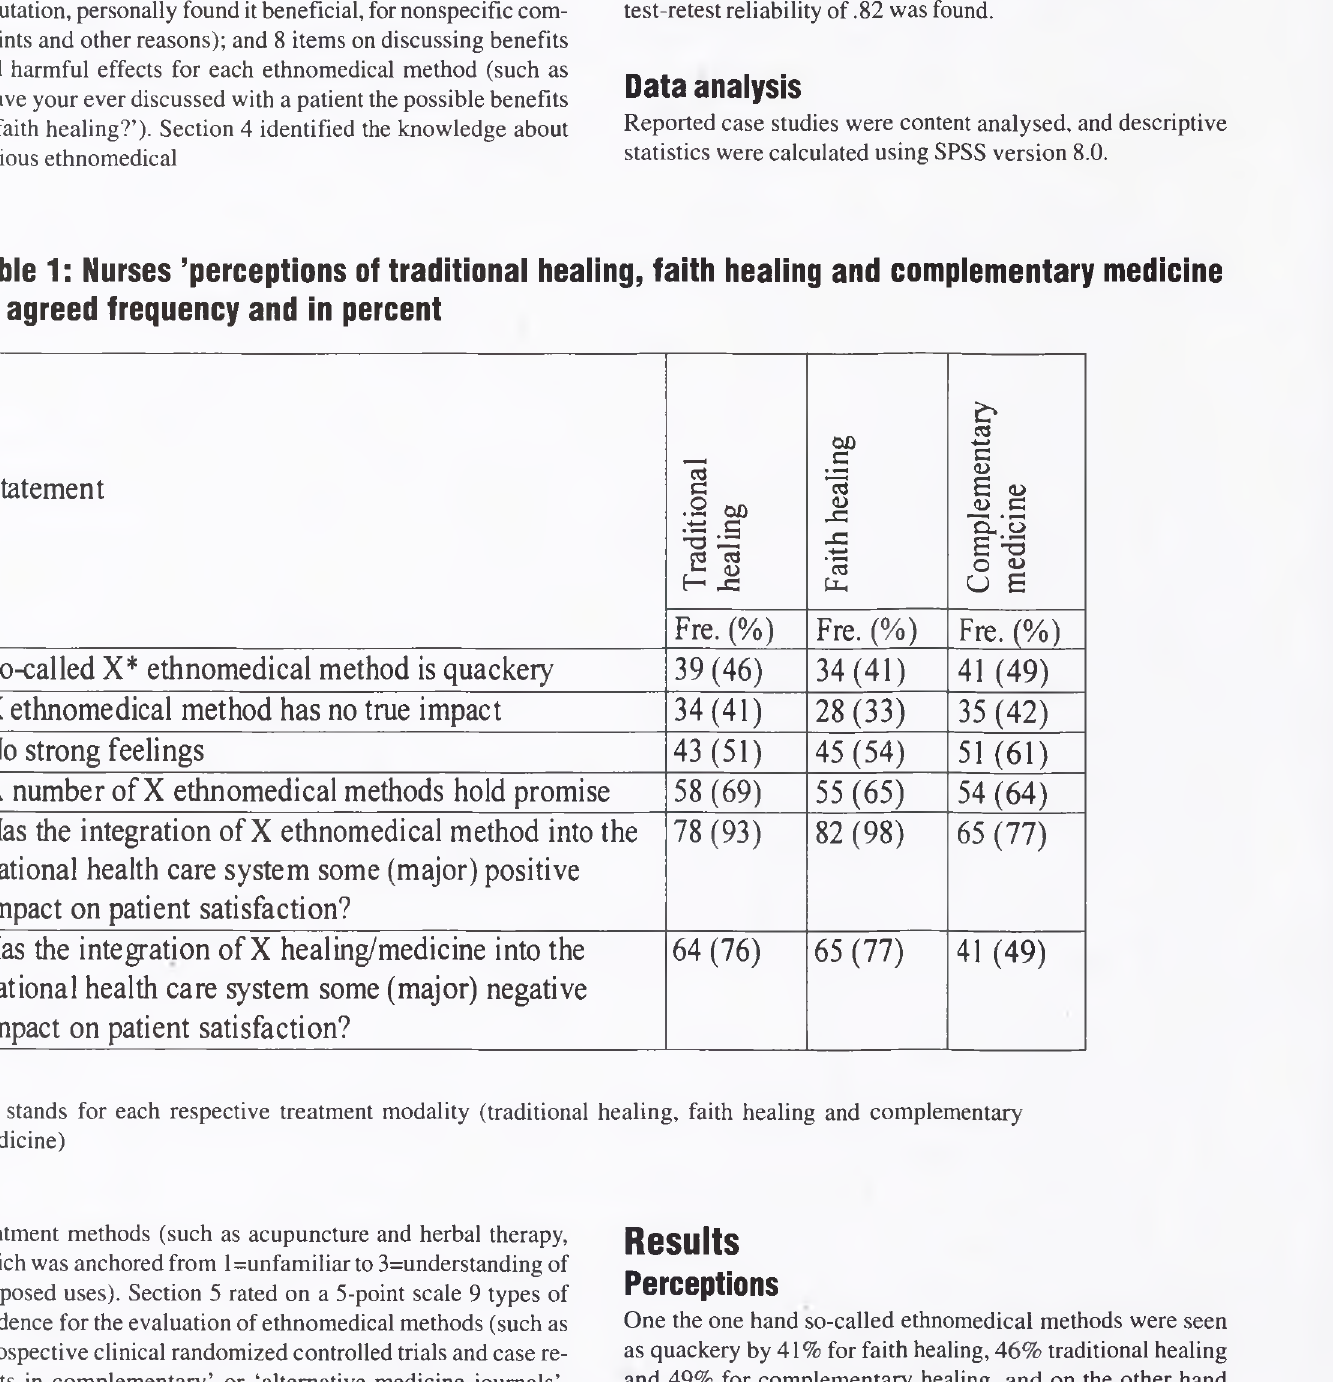
Table 1: Nurses ’perceptions of traditional healing, faith healing and complementary medicine by agreed frequency and in